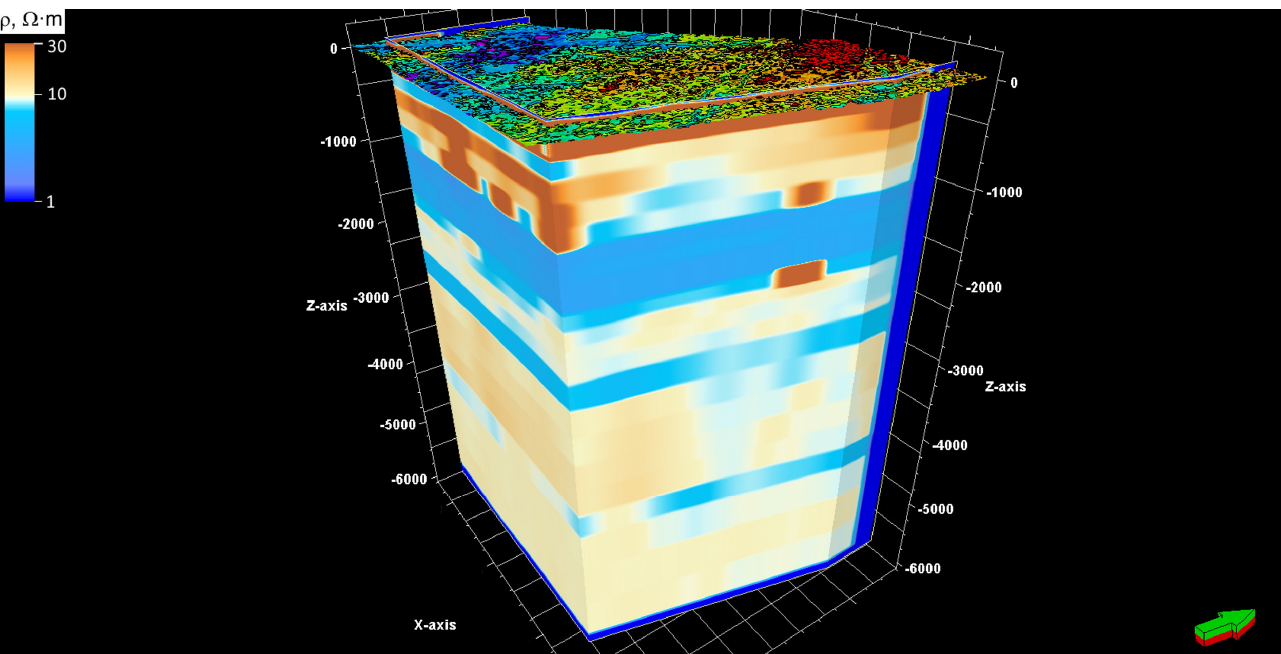
Figure 5. Example of Shallow TEM and 3D TEM results from Arctic region: composite sTEM + 3D TEM resistivity cube.